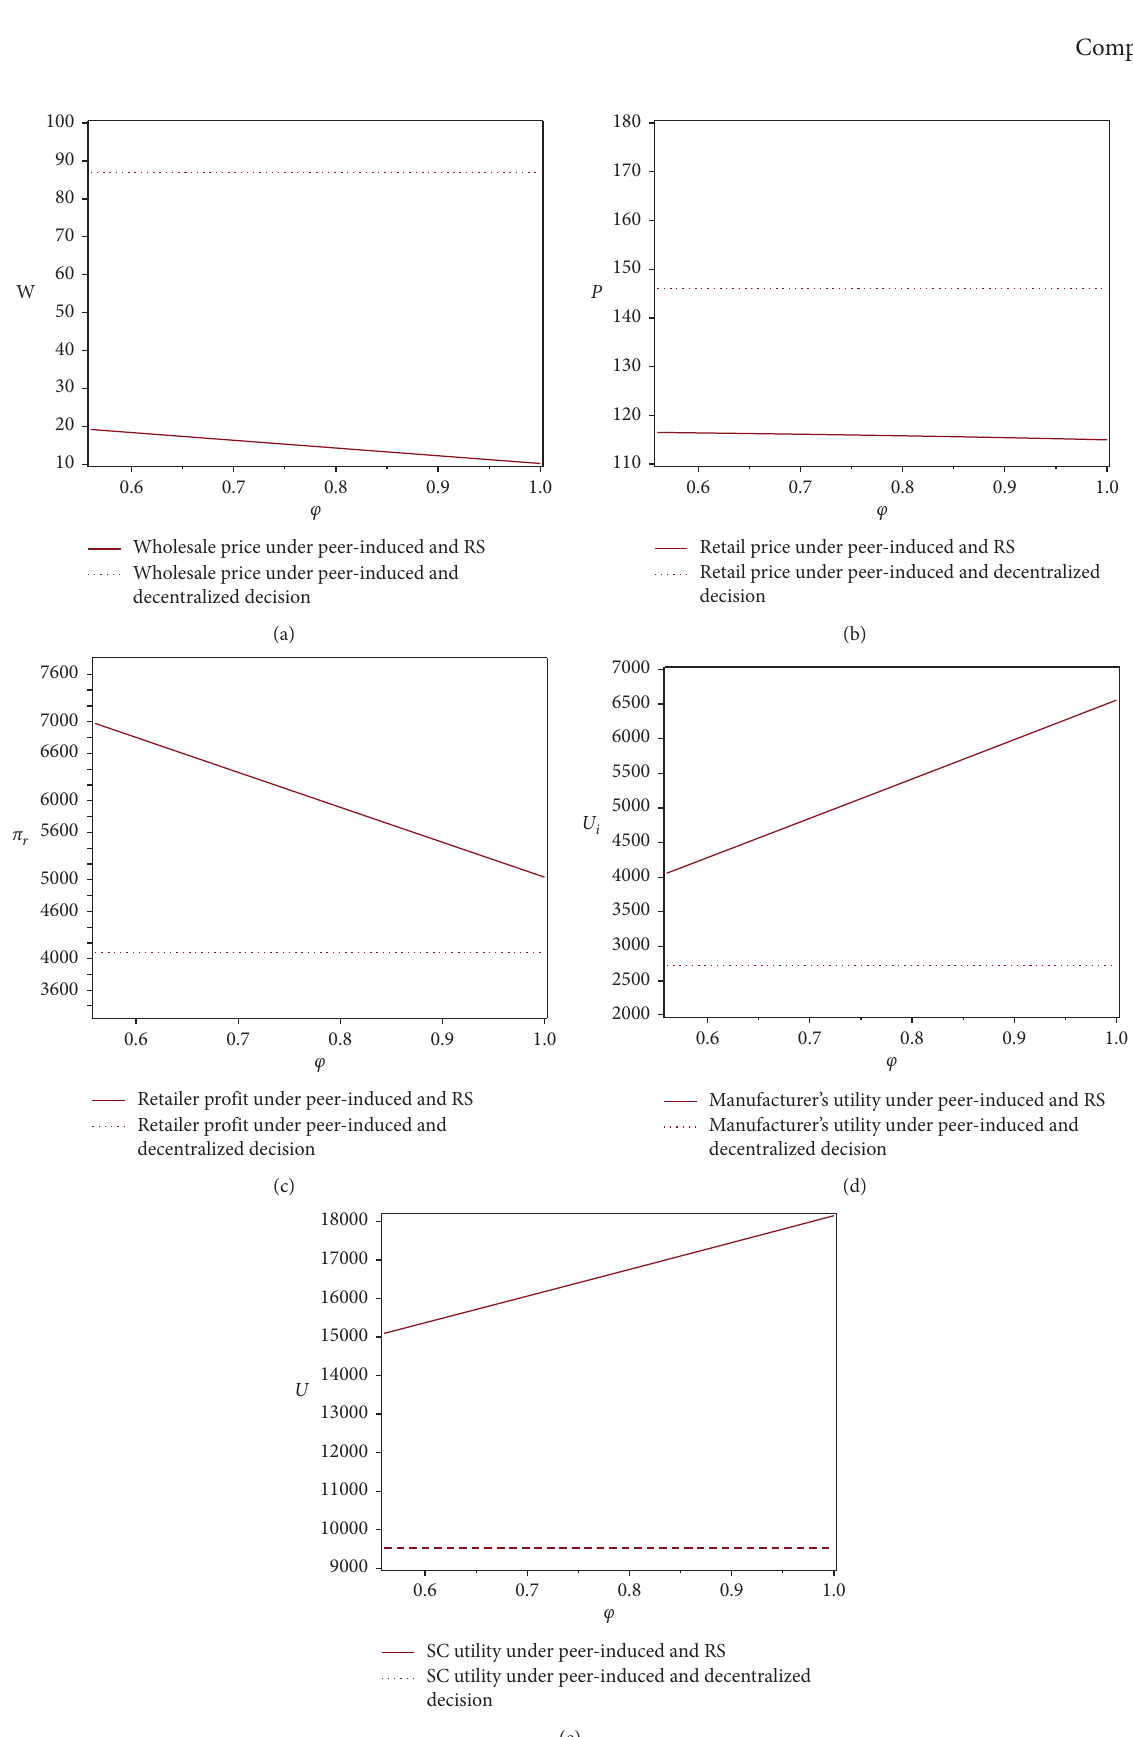
Figure 1: Effect of RS contract on supply chain of manufacturer’s peer-to-peer-induced equity concern: (a) the impact of RS on W-Price; (b) the impact of RS on R-Price; (c) the influence of RS on retailer profit; (d) the influence of RS on manufacturer profit; (e) the influence of RS on the total utility of supply